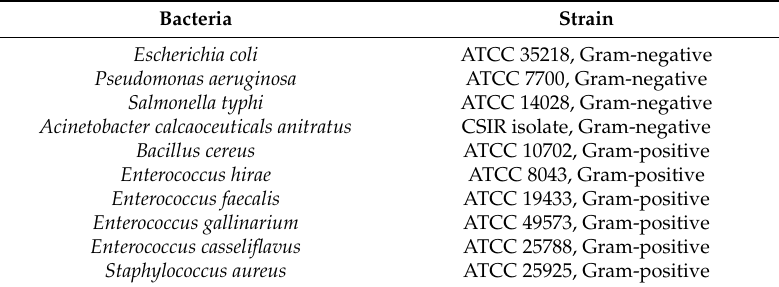
Table 5. Bacterial test organisms used in this